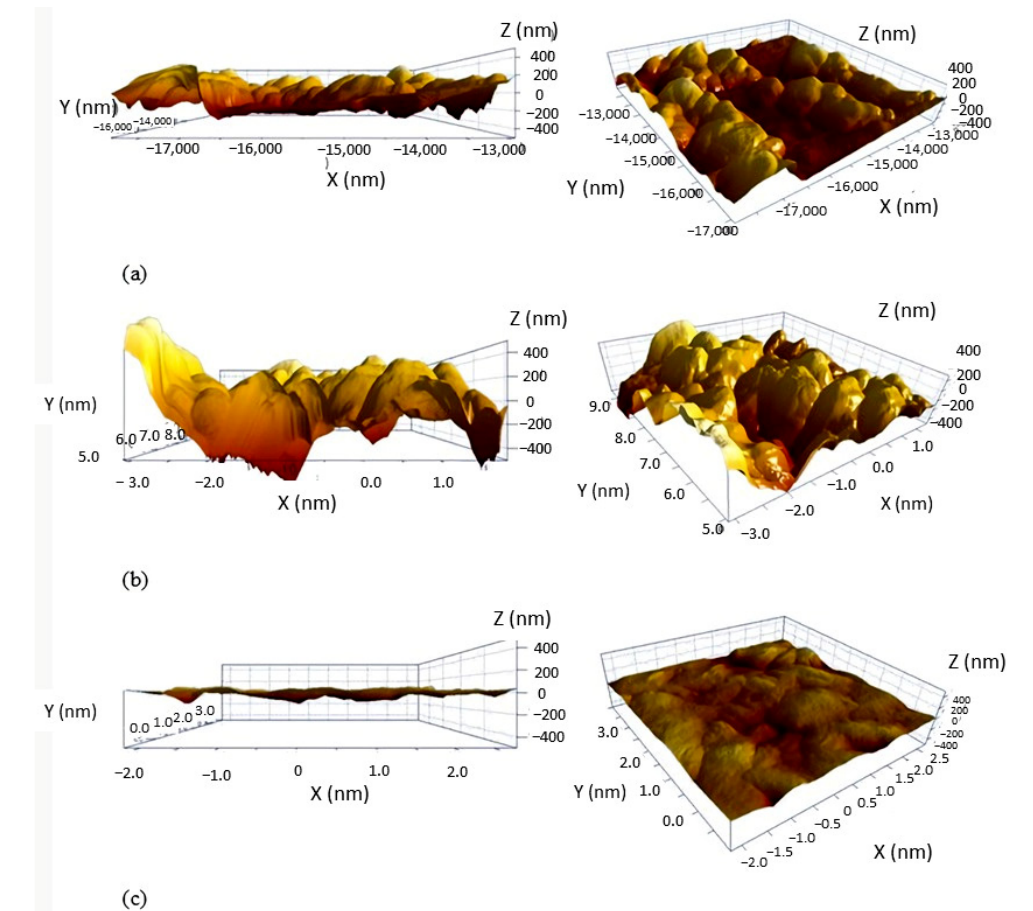
Figure 11. The AFM images of ( a ) SiO 2 -TiO 2 -MTMS, ( b ) SiO 2 -TiO 2 -OTMS, and ( c ) SiO 2 -TiO 2 -HDTMS coatings.